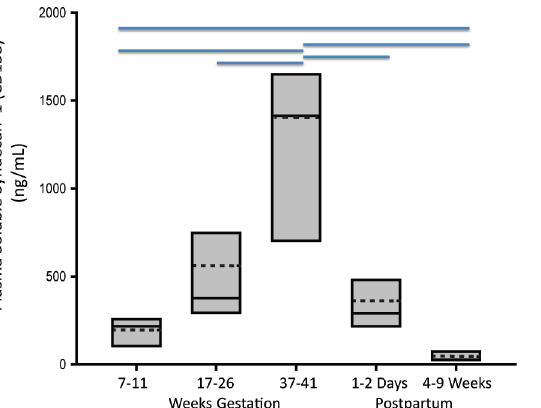
Fig 1. Soluble Sdc1 concentrations increased significantly with advancing gestation. Box-plot of soluble Sdc1 concentrations in maternal plasma as a function of successive gestational weeks (W) and postpartum stages, of n = 8 women with uncomplicated pregnancy outcome. The solid and dotted lines through the interior of the boxes correspond to median and mean values, respectively. The top and bottom of each box correspond to 75 th and 25 th percentiles, respectively. Horizontal lines on the top of the graph indicate significant differences between the time points (P < 0.05; Repeated Measures Analysis of Variance on Ranks with post hoc Student-Newman-Keuls